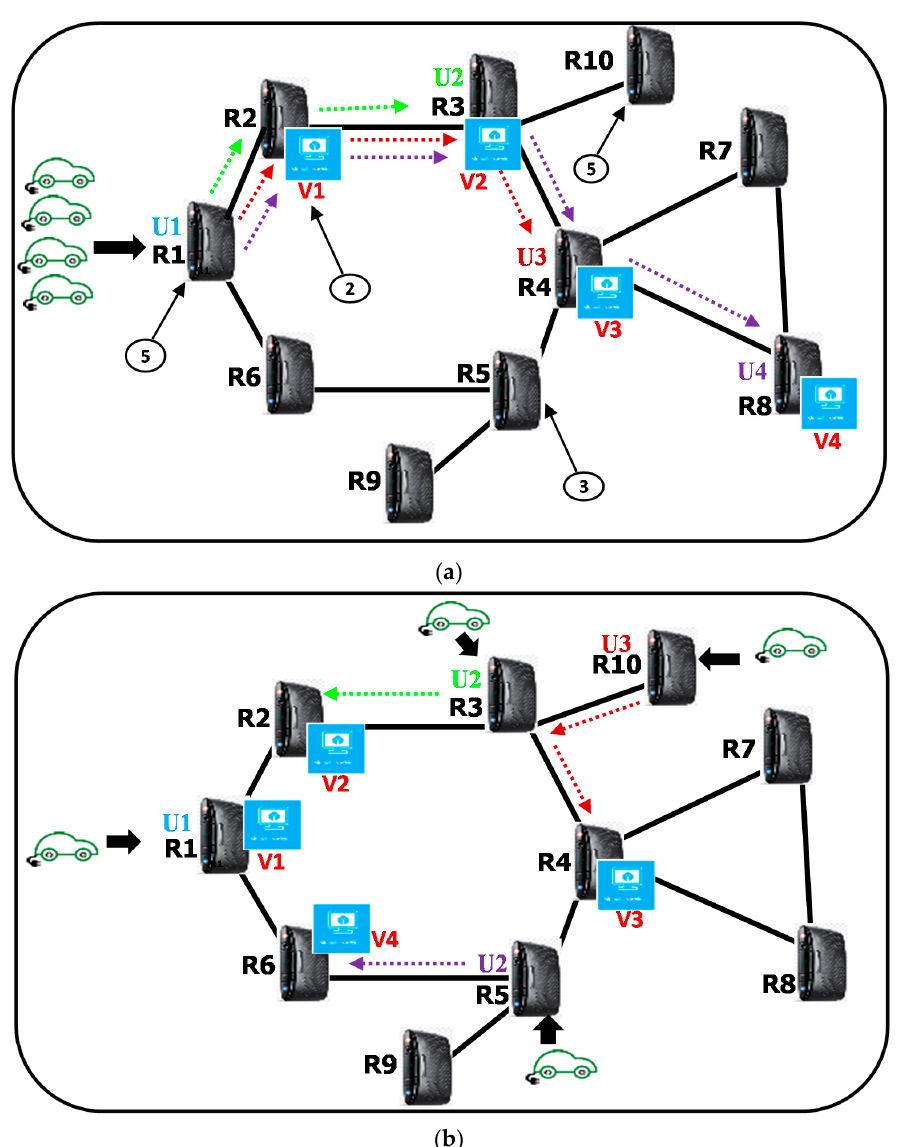
Figure 3. ( a ) Task association and virtual machine (VM) deployment scenario 1. ( b ) Task association, VM deployment scenario 2.